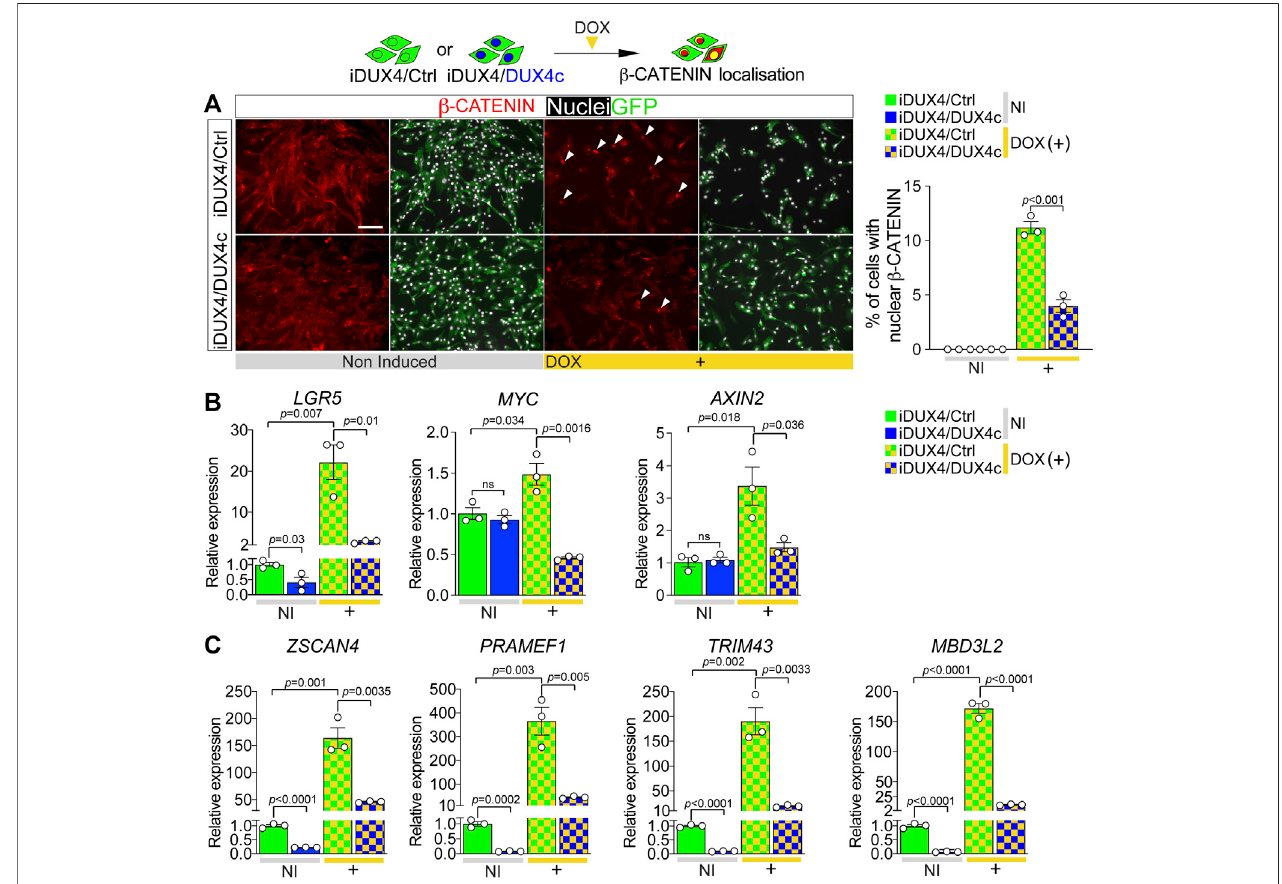
FIGURE5| DUX4creducesDUX4-induced β -CATENIN signallingand expression ofDUX4target genes. (A) RepresentativeimagesofproliferatingiDUX4/Ctrland iDUX4/DUX4c myoblasts induced with 62.5 ng/ml DOX (+) and co-immunolabelled for β -CATENIN (red) and GFP (green), with nuclei counterstained with DAPI (white). Arrowheads indicate iDUX4/Ctrl myoblasts with nuclear β -CATENIN in DOX-treated samples. Scale bar equals 100 µm. Quanti fi cation of the percentage of iDUX4/Ctrl and iDUX4/DUX4c myoblasts with nuclear β -CATENIN when non-induced (NI) or after treatment with 62.5 ng/ml DOX (+). β -CATENIN nuclear localisation in DOX- induced iDUX4/Ctrl myoblasts is signi fi cantly higher than in DOX-induced iDUX4/DUX4c myoblasts. N = 3 biological replicates, ANOVA, Tukey ’ s posthoc test. (B) RT- qPCR analysis on iDUX4/Ctrl and iDUX4/DUX4c myoblasts when non-induced (NI) or after treatment with 62.5 ng/ml DOX (+) for 24 h showing up-regulation of the β - CATENINtargetgenes LGR5,MYC, and AXIN2 uponDUX4inductioniniDUX4/Ctrlcomparedtonon-inducedcontrolbutnotinDOX-inducediDUX4/DUX4cmyoblasts. N=3biologicalreplicates,ANOVA, unpairedtwotailedt-test. (C) RT-qPCRanalysisoniDUX4/CtrlandiDUX4/DUX4cmyoblaststreatedasinB,showingtherepressive effect of constitutive DUX4c expression on the DUX4 target genes ZSCAN4 , PRAMEF1 , TRIM43 , and MBD3L2 mRNA levels compared to iDUX4/Ctrl in both non- induced and DOX-induced iDUX4/DUX4c. N = 3 biological replicates, ANOVA, Tukey ’ s posthoc test. Relative expression as fold change to NI iDUX4/Ctrl sample is reported. Graphs report mean ± SEM with statistical signi fi cance between speci fi c samples indicated by a bar.